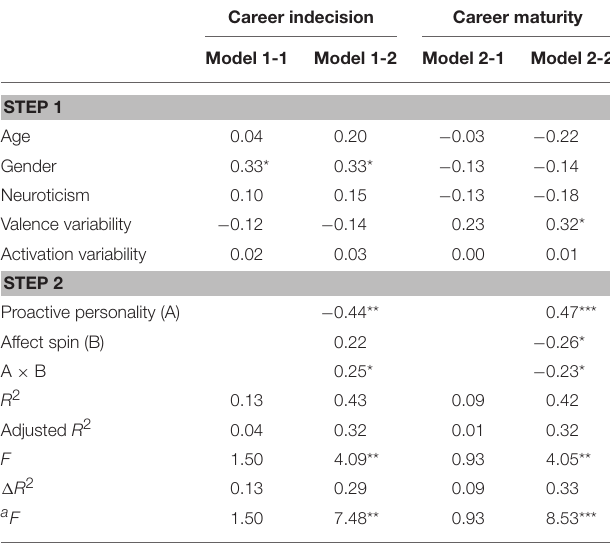
TABLE 2 | Results of hierarchical regression analyses predicting career indecision and career maturity.